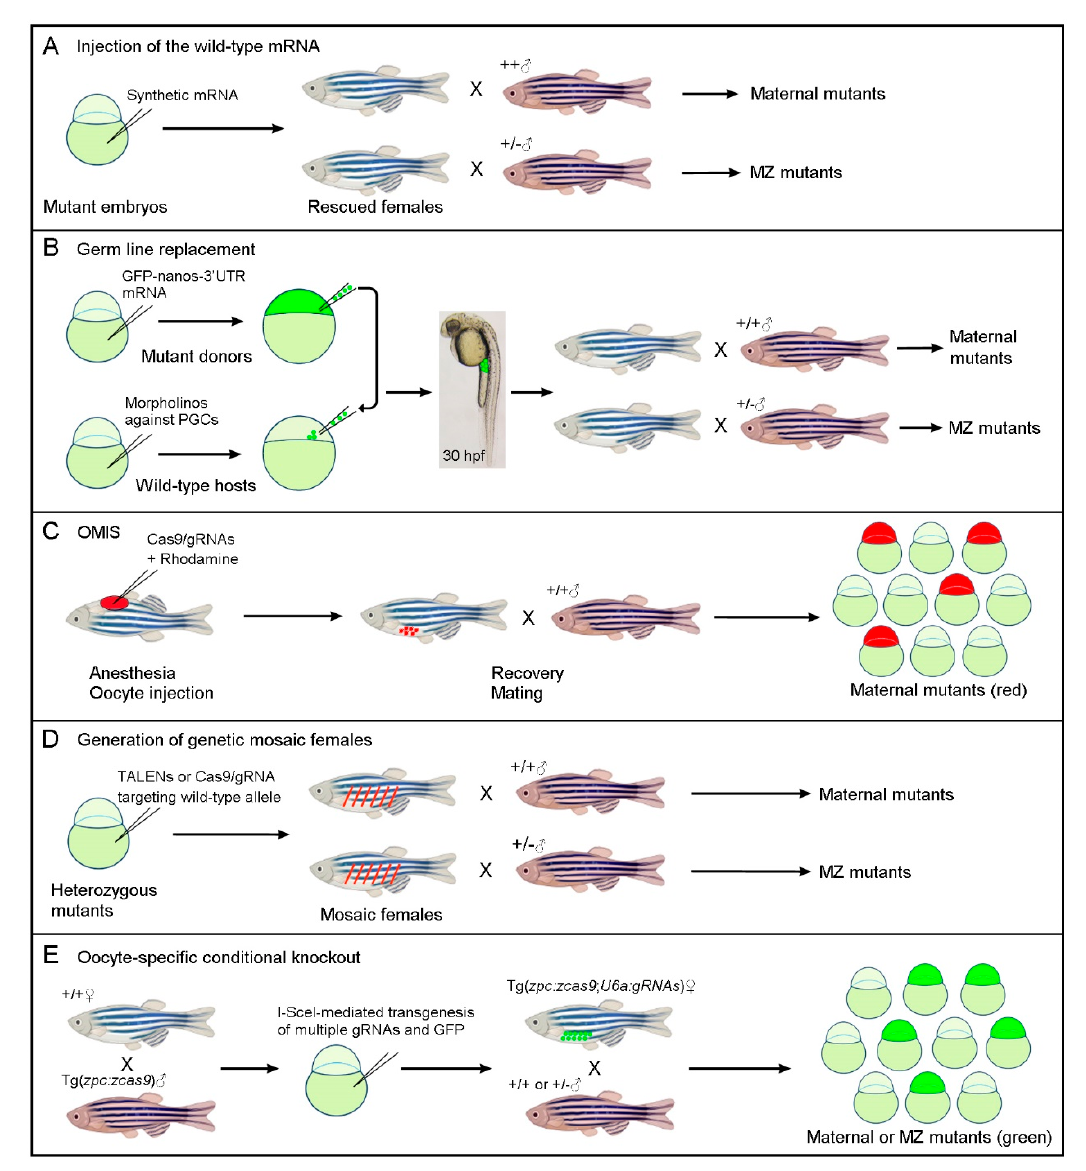
Figure 1. Simplified schematic representations of different strategies for generating maternal or MZ mutants by circumventing zygotic lethality. ( A ) Rescue of zygotic lethal phenotypes through the injection of the wild-type mRNA into fertilized homozygous mutant embryos. ( B ) Germ-line re- placement through the transfer of zygotic lethal mutations to wild-type host embryos, in which PGCs are ablated by the morpholino-mediated inhibition of Dead-end protein function.